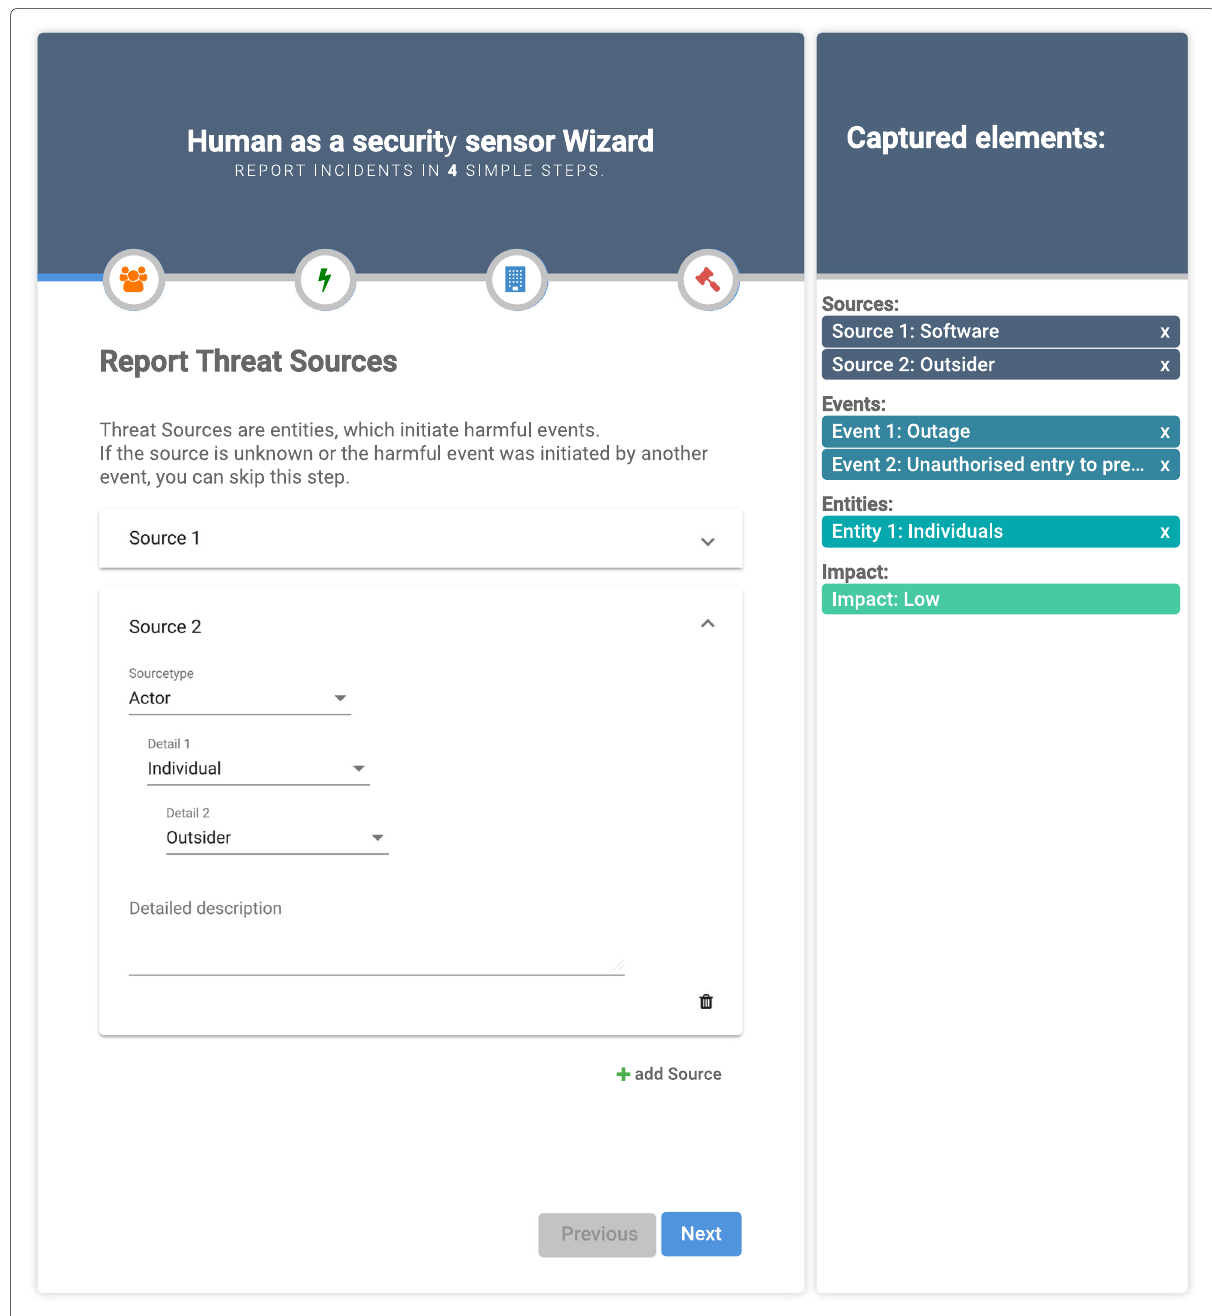
Fig. 4 Screenshot of the wizard for reporting incidents by humans